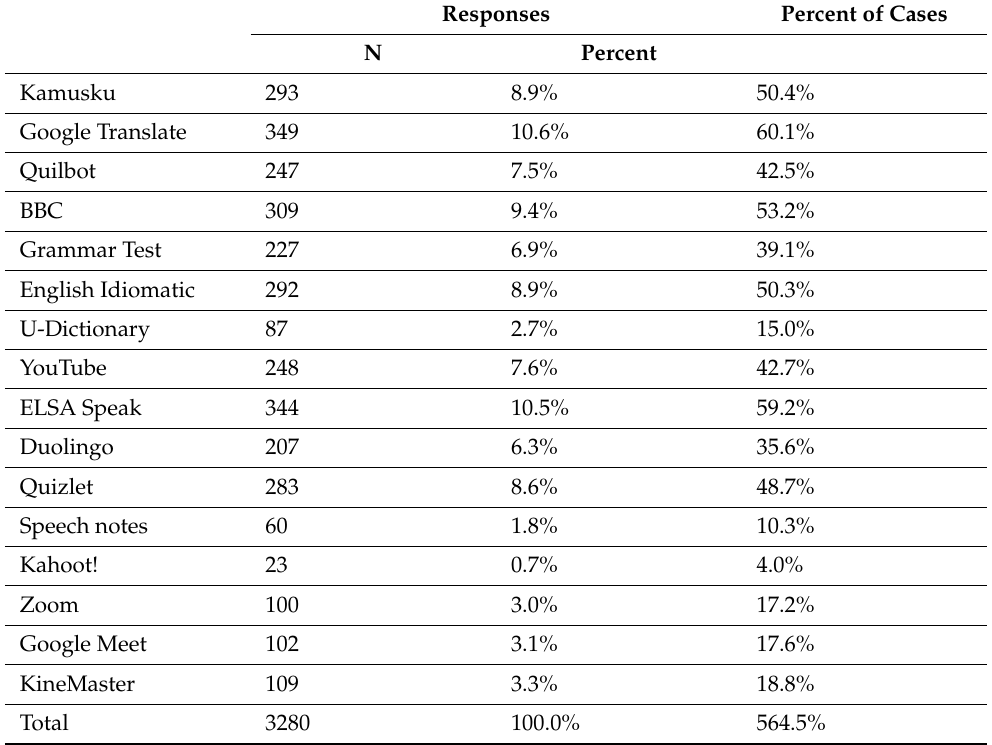
Table 2. Mobile assisted language learning software use pattern.